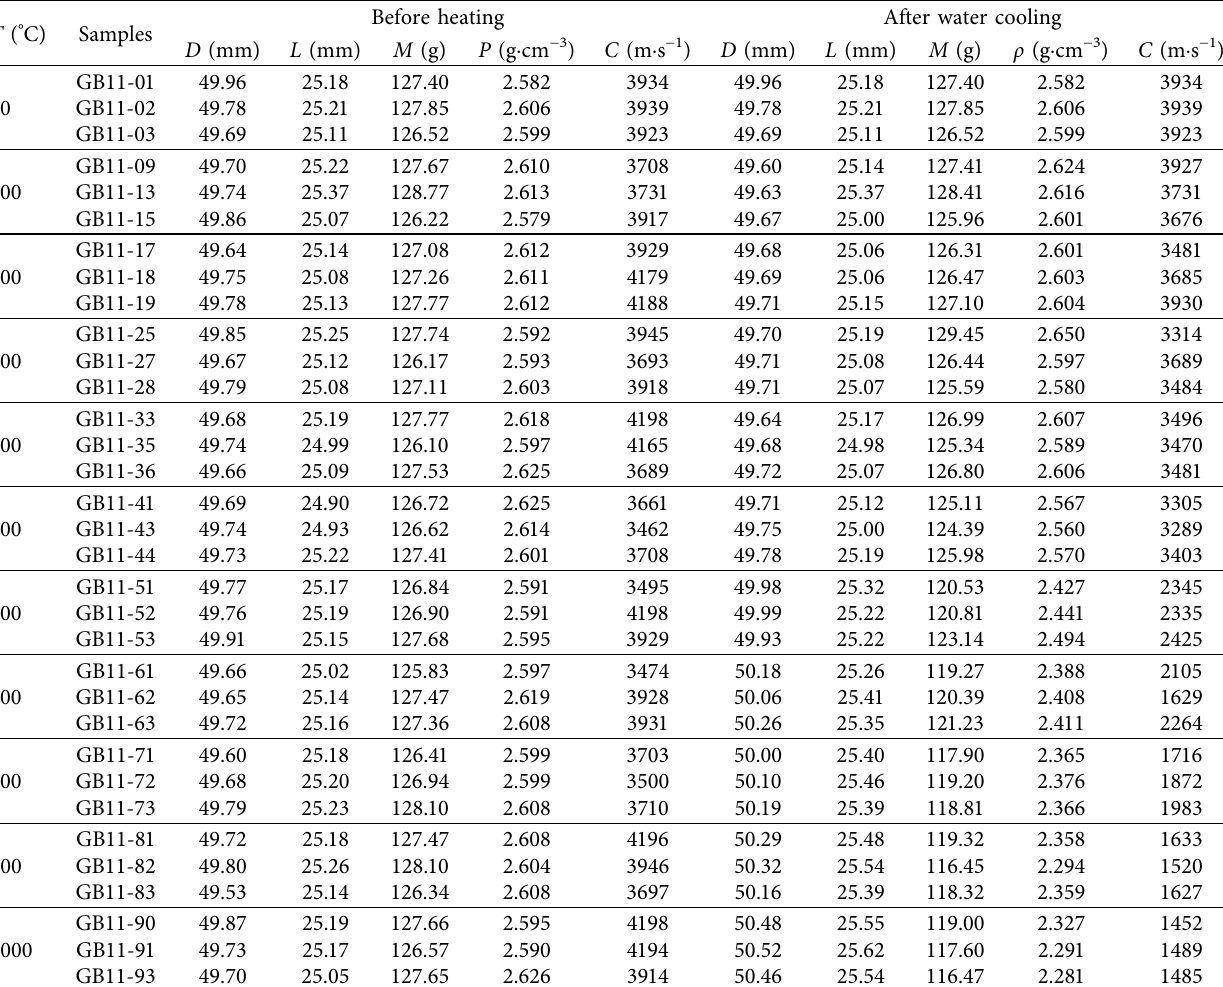
Table 1: Basic physical parameters of sandstone before heating and after water